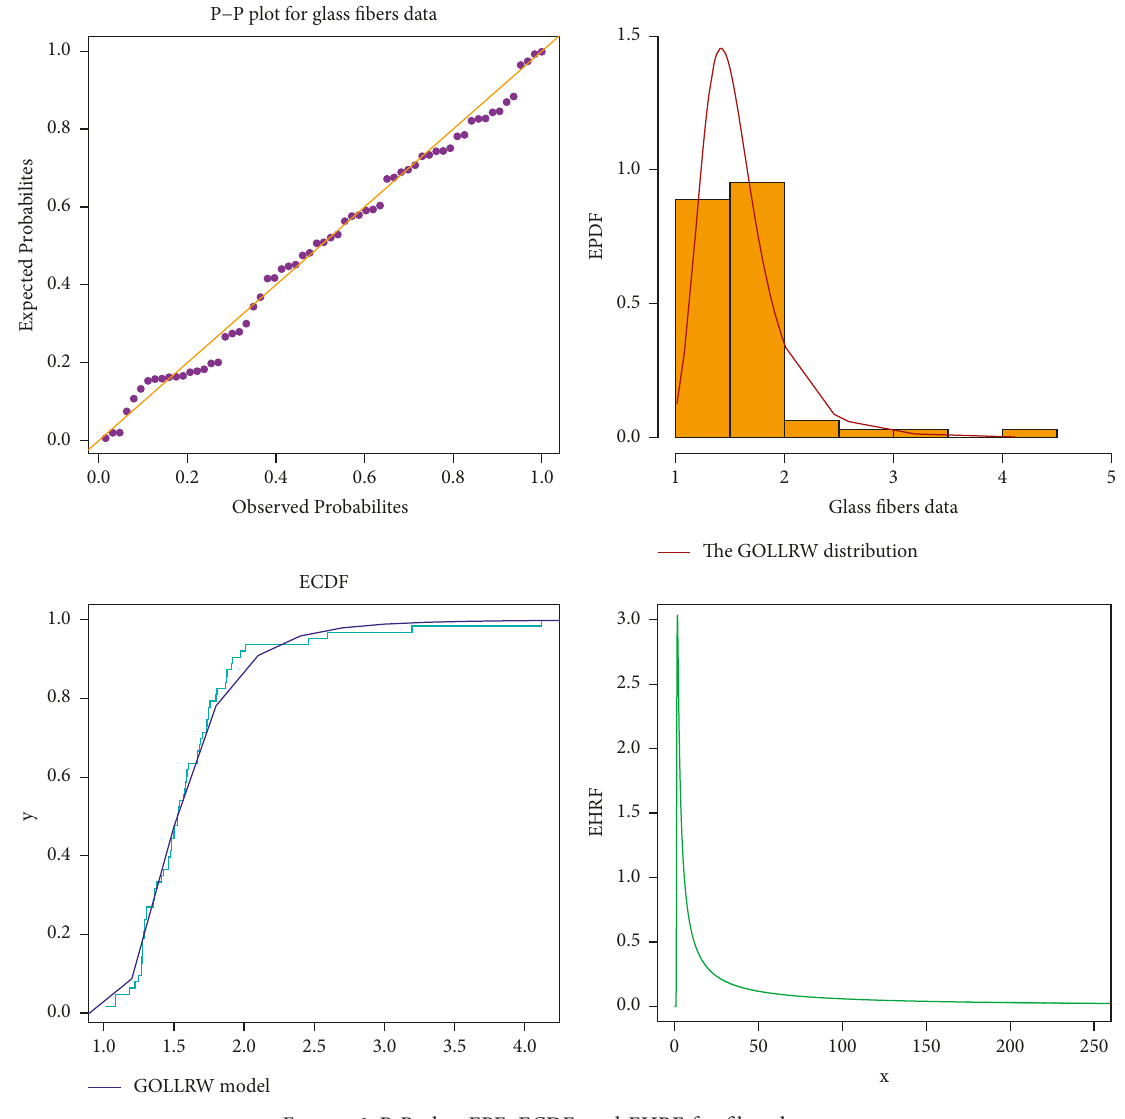
Figure 6: P-P plot, EPF, ECDF, and EHRF for fiber data set. Table 10: C ₁ , C ₂ , KS-test, and P.V for fiber data